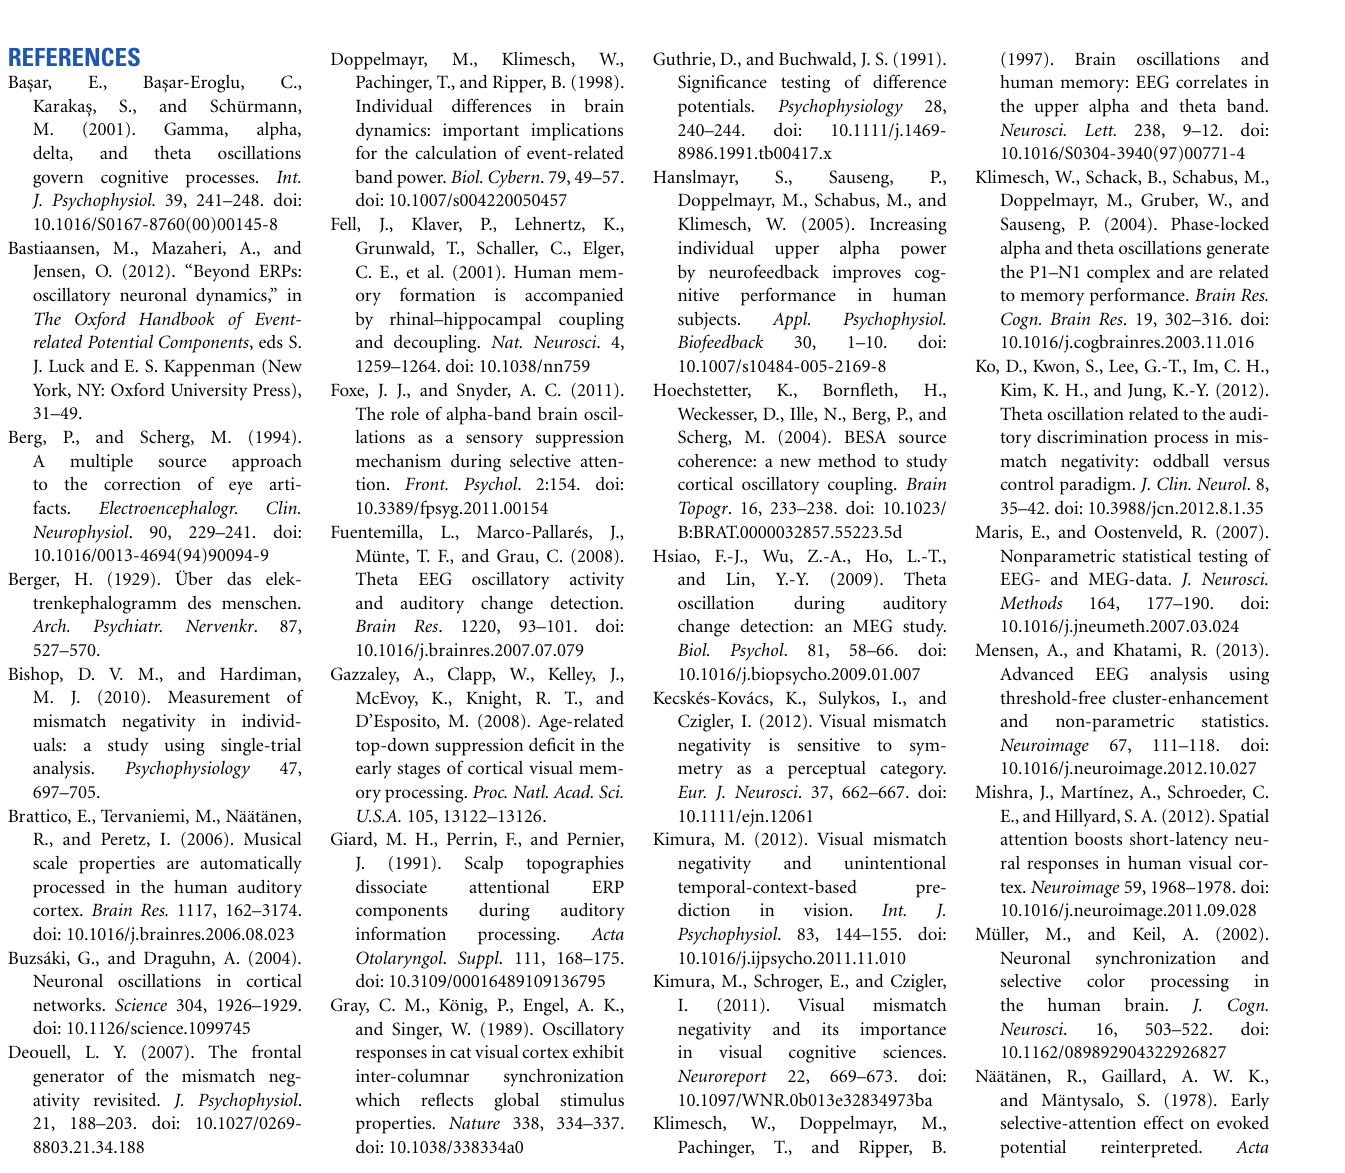
Supplementary Figure A | Sixty-four channel grand average plots for all time-frequency analyses for (A) standard, (B) deviant and (C) significant difference t -values (i.e., deviant minus standard, p < 0.05) after Monte Carlo permutation correction for multiple comparisons. Non-significant differences are masked in white. X and Y axes scales for all electrode plots are indicated by the blank plot at the bottom of the figure. It should be noted that statistical data is based on the cluster based permutation analyses across all channels, timepoints and frequencies, i.e., controlling for multiple comparisons across spatial/temporal/spectral dimensions. Electrodes are presented in the plots individually in order to show the presence and absence of effects at each electrode in a more detailed manner than using scalp